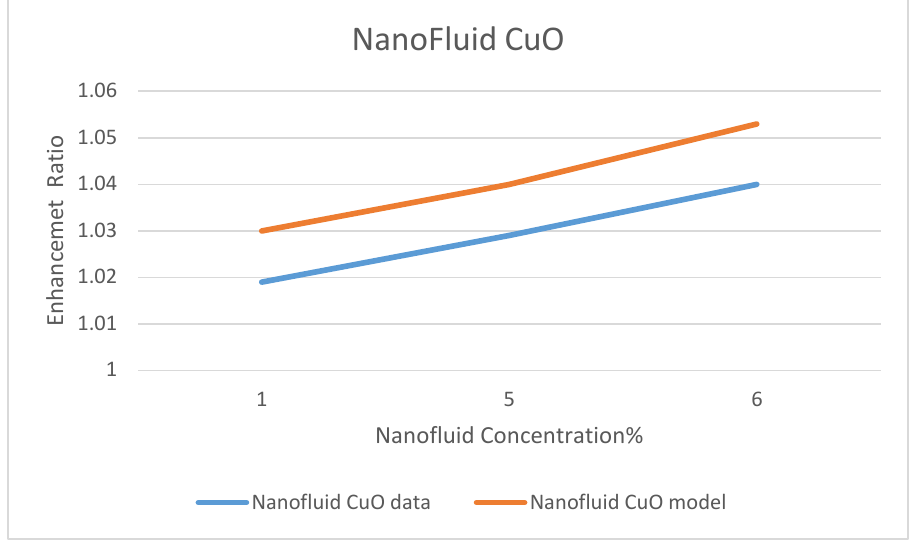
Figure 32. Comparison between model and data of Bellos and Tzivanidis [35].